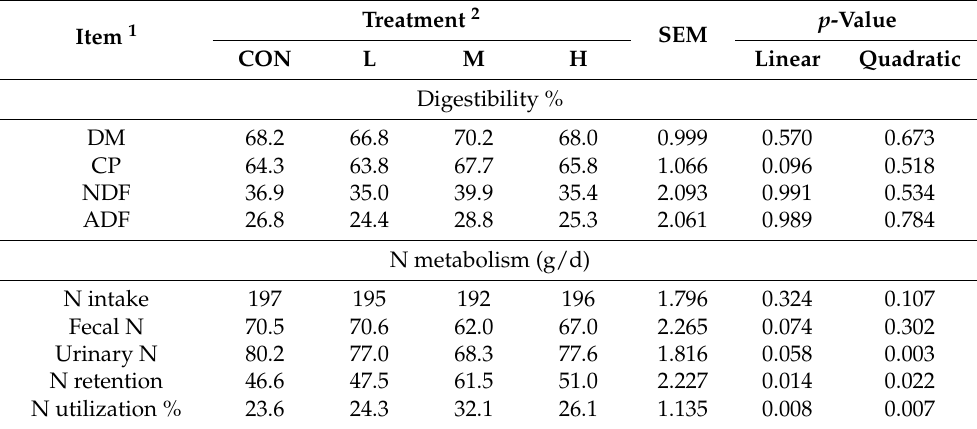
Table 3. Effect of supplementation with N-carbamylglutamate (NCG) on apparent digestibility and N metabolism in fattening Holstein